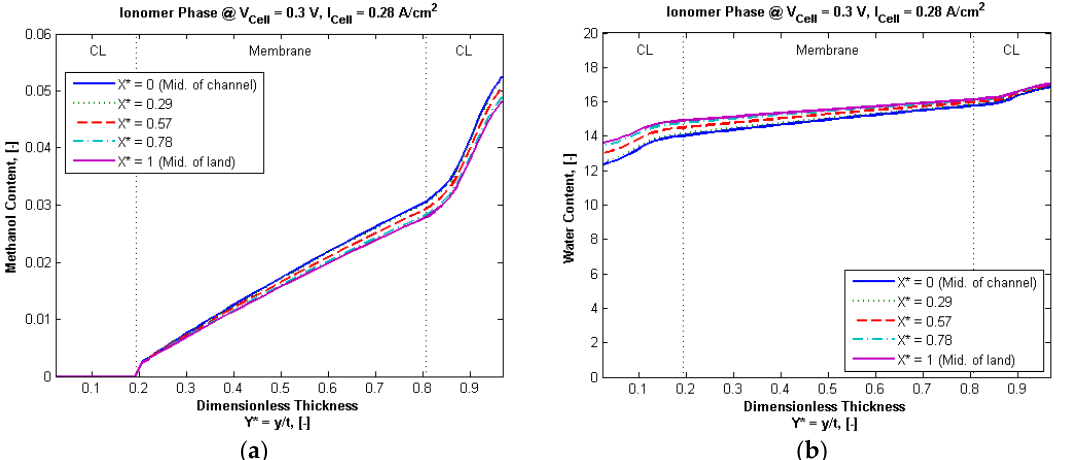
Figure 8. ( a ) Membrane methanol content for GDL porosity of 0.75 at cell voltage of 0.3 V and current density of 0.17 A/cm 2 ; ( b ) membrane water content distribution for GDL porosity of 0.75 at cell voltage of 0.3 V and current density of 0.17 A/cm 2 .